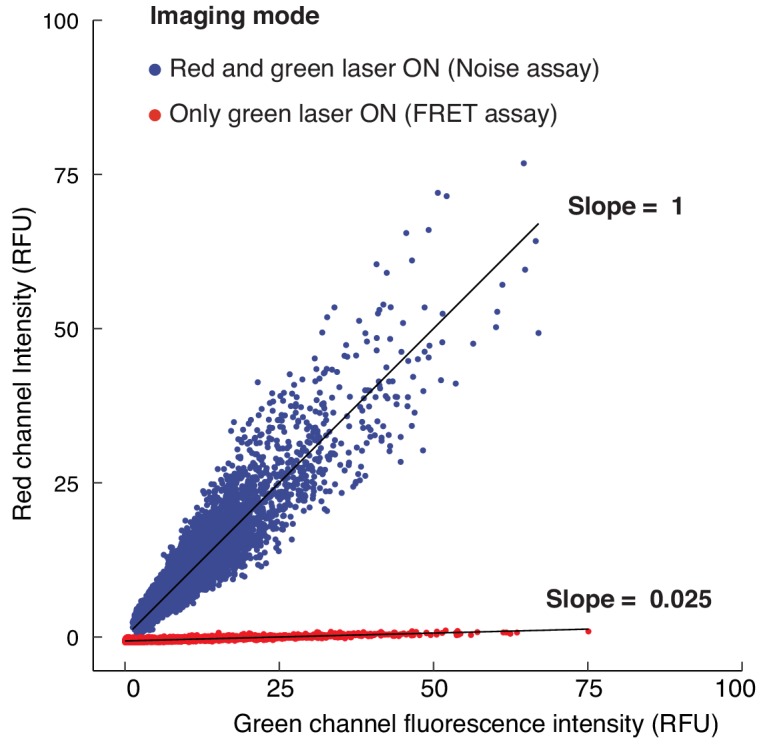
Fluorescence Resonance Energy Transfer (FRET) from sfGFP to mCherry molecules is negligible under experimental imaging conditions.Wing disc cells with tandem tagged sfGFP-mCherry-sens alleles were imaged under identical conditions with either both green and red lasers ‘on’ to assay stochastic noise, or with only the green laser ‘on’ to assay FRET from sfGFP to mCherry molecules. Raw single cell green channel fluorescence intensity is plotted on the x-axis. All cells in the imaging field were included for analysis. Red channel fluorescence values, on y-axis, were linearly transformed to make the slope equal to 1 and y-intercept equal to 0 for noise assay data. Single cell red fluorescence values for FRET assay data were then transformed with identical parameters for comparison.